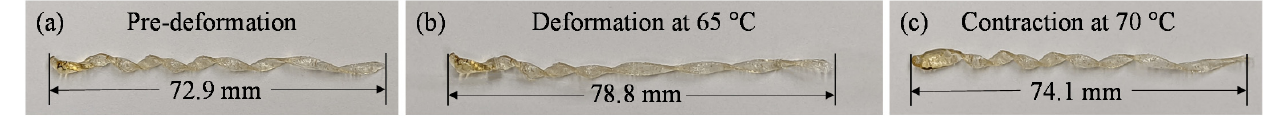
Figure 8. Artificial muscle ( a ) before deformation and ( b ) deformation at 65 °C. ( c ) Contraction of the programmed artificial muscle at 70 °C.